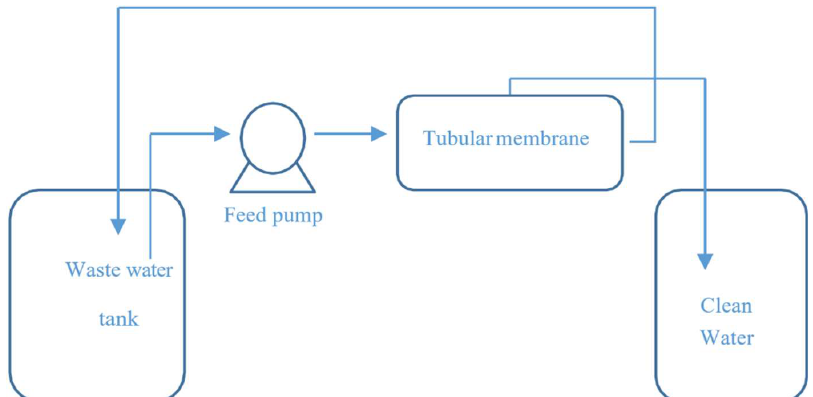
Figure 5. Schematic of experimental filtration.